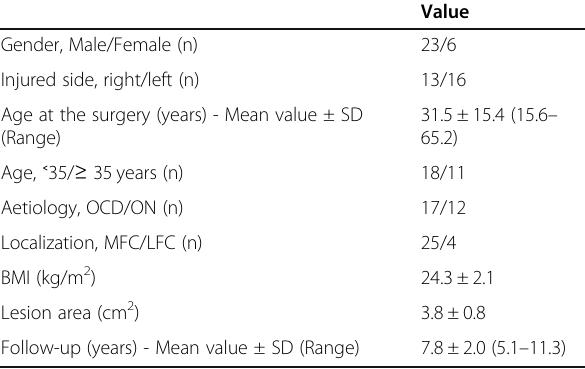
Table 1 Demographic and lesion related